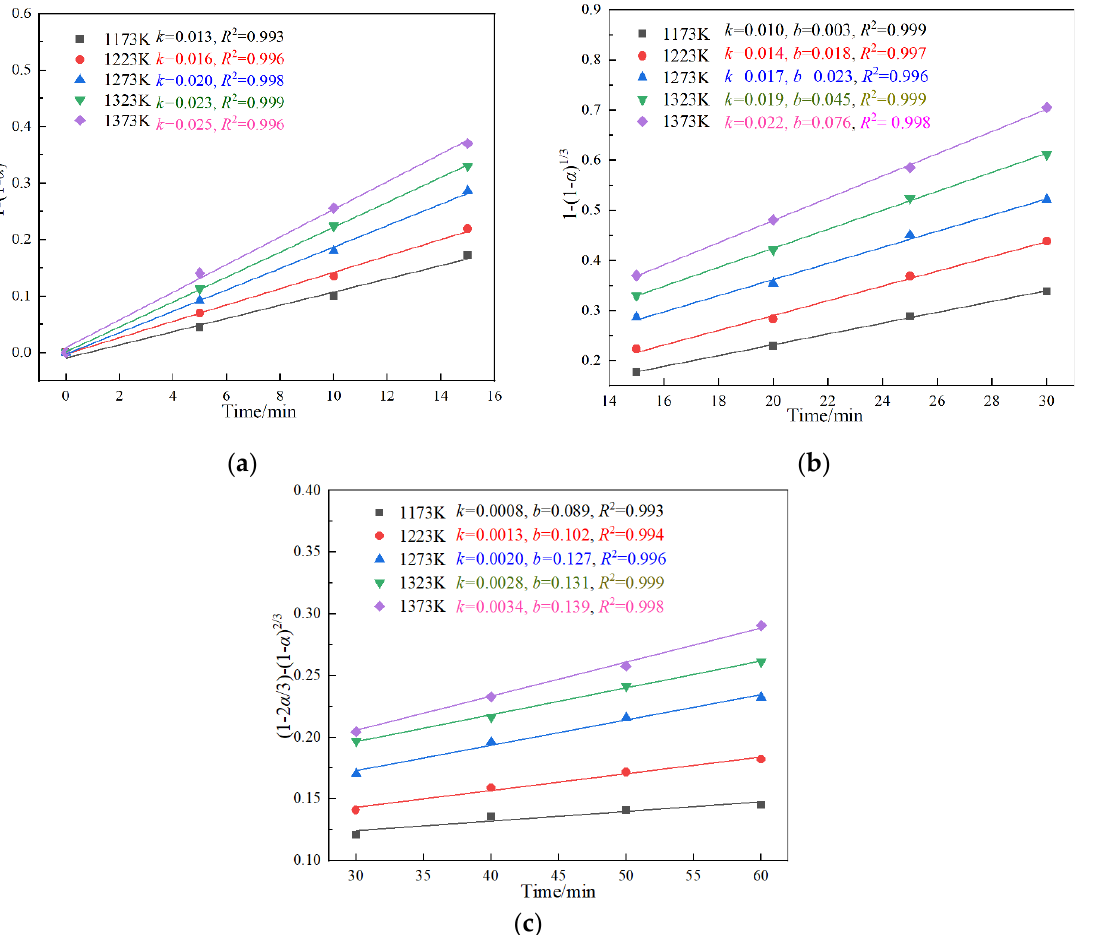
Figure 9. Relationship between F ( α ) and time at different temperatures: ( a ) 0 < t < 15 min; ( b ) 15 < t